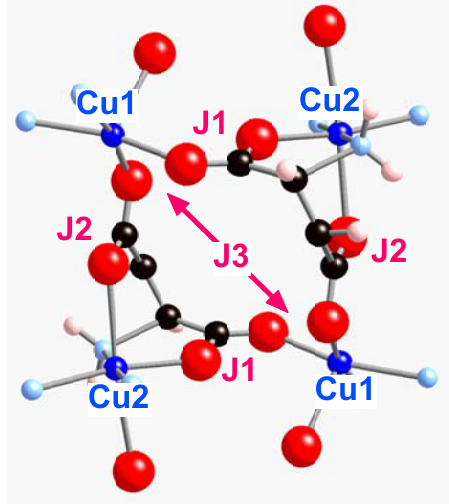
Figure 5 . Three-dimensional view of the magnetic structure for each Cu II tetramer (see Figures 2a-b for specific geometries), indicating the non-negligible microscopic J pair interaction parameters (bpy rings are omitted for clarity). AB